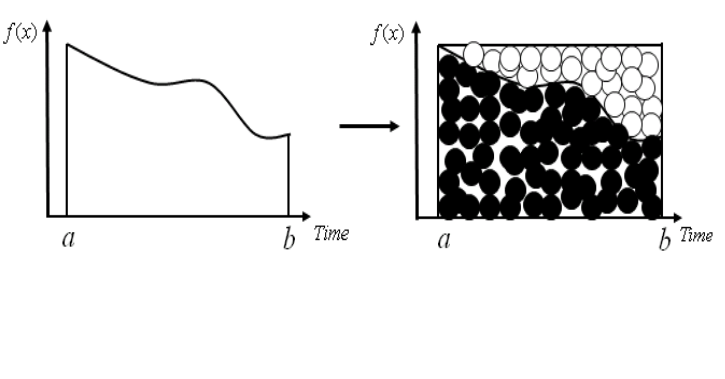
Figure 1. Monte Carlo integral calculus